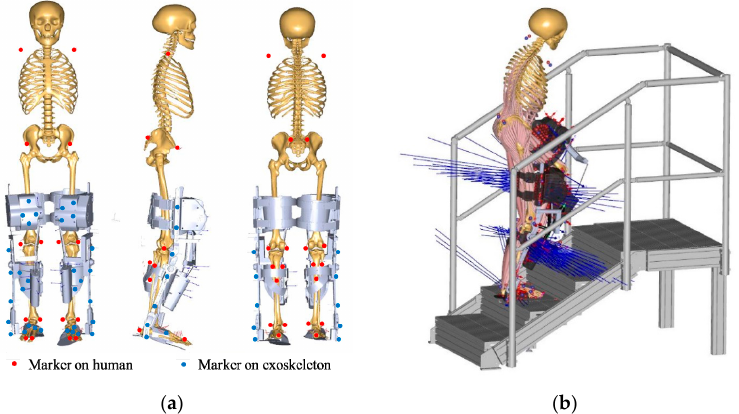
Figure 4. ( a ) Marker placement on the human and exoskeleton [29]. Markers on the human: two at the shoulders, four at the pelvis, four at the knees, six at the shanks, four at the ankles, and six at the feet. Markers on each exoskeleton leg: four at the thigh segment, three at the thigh rail, three at the shank segment, three at the shank lower rail, one at the foot rail, and four at the foot segment; ( b ) Human-exoskeleton-model during the inverse calculation of a stair ascent [4].